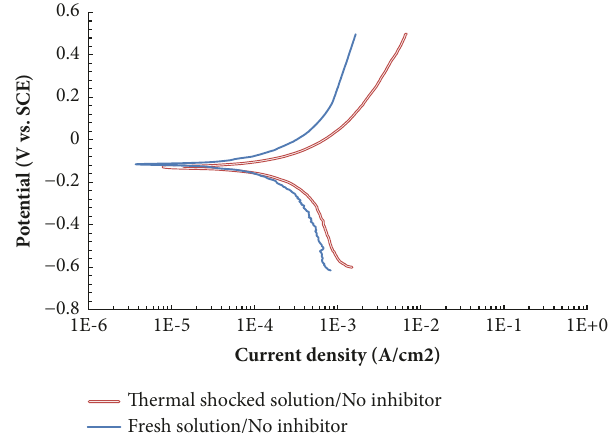
Figure 4: The corrosion behavior of aluminum alloy 3303 in galvanic coupling state with five other metals in the fresh and thermal shocked water-ethylene glycol solution without